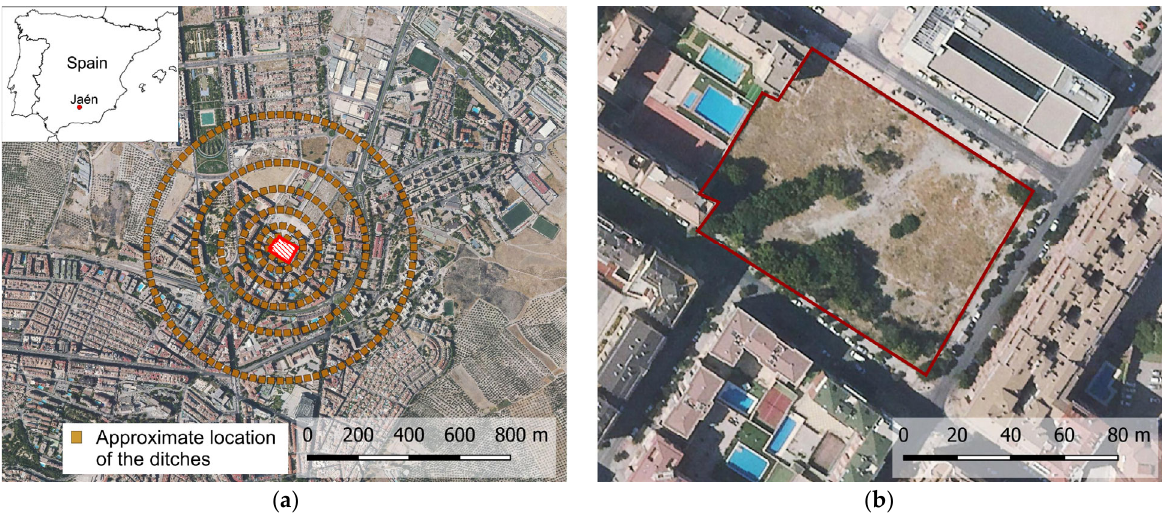
Figure 3. Location of the archaeological area involved in this study: ( a ) location of Marroquíes Bajos; ( b ) archaeological area documented in this study.